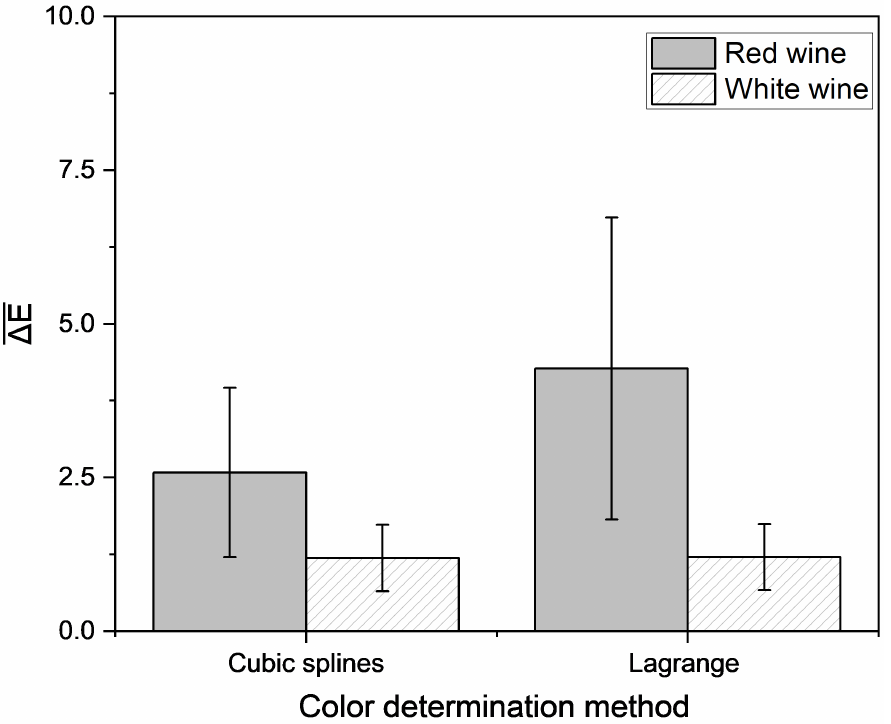
Figure 8. Mean Euclidean color distance in the CIE L*a*b* color space based on different empir- ical methods and the reconstructed transmission spectra, determined by different interpolation approaches compared with the color determination method according to OIV [51]. Transmission data were measured with a portable photometer and compared to data measured with the laboratory photometer. Mean and 95% confidence interval of 46 red and 46 white wines are